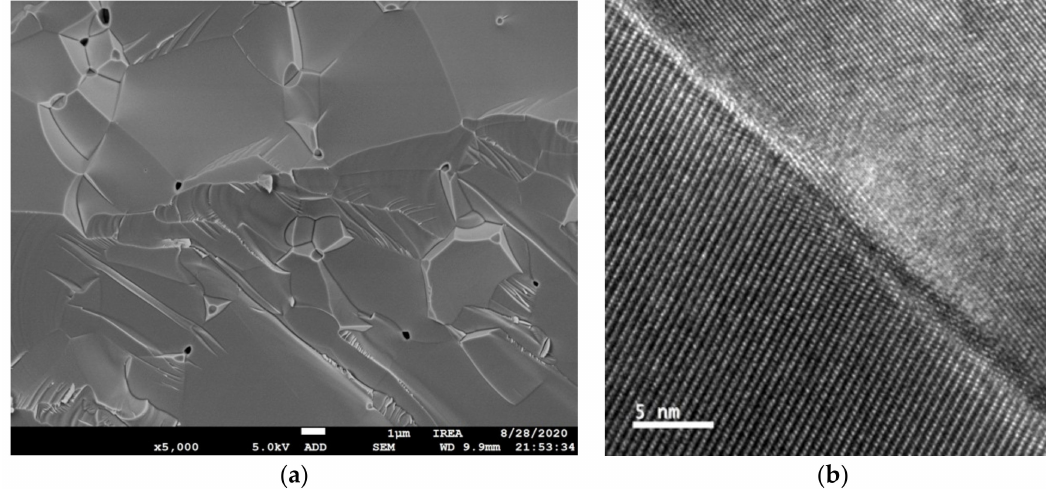
Figure 2. SEM image of (Gd,Y) 3 Al 2 Ga 3 O 12 :Ce ceramics, polished and thermally etched, in backscattered electrons mode showing grain structure ( a ) and intergrain boundary ( b ), after